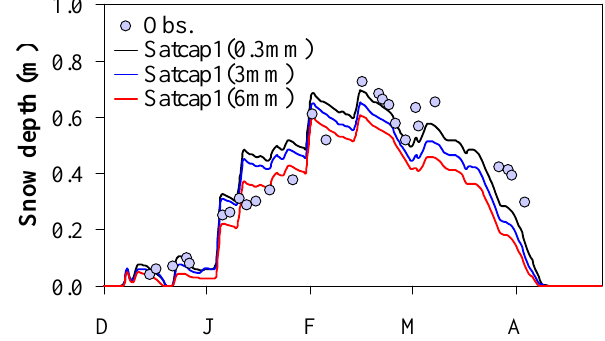
Fig. 9. Comparison of observed and WEB-DHM-S simulated snow depth for different maximum canopy snow storage ( Satcap1 ) at the HSG forest